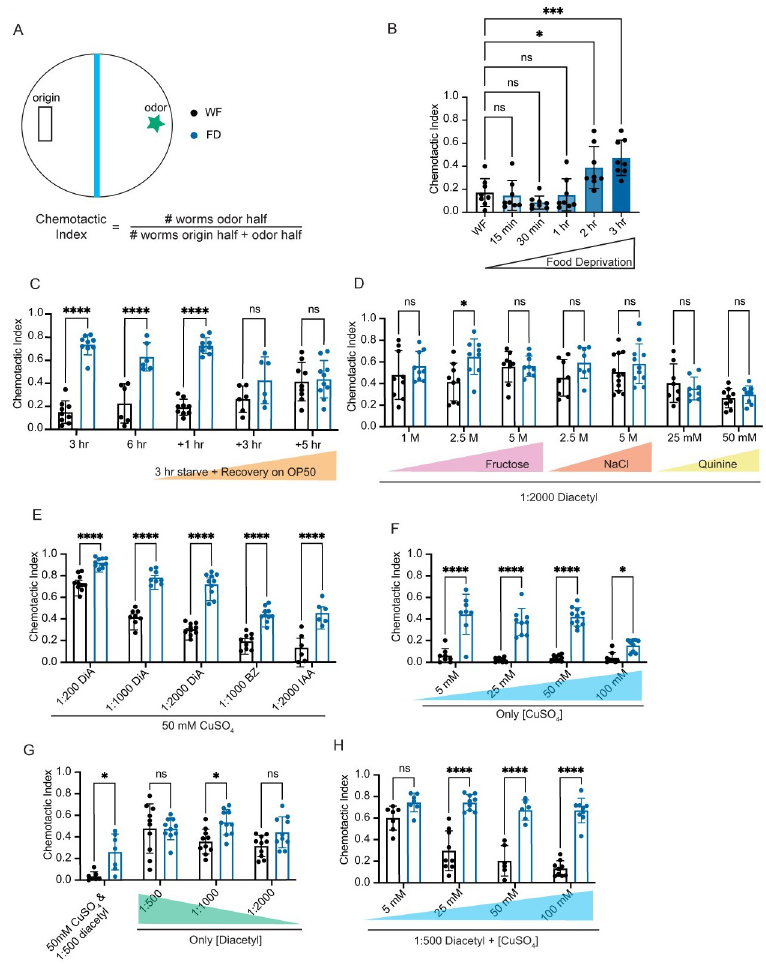
Fig 1. Starvation reduces copper avoidance. A) Schematic of the sensory integration assay. ~100–200 day 1 adult animals (n) are placed in the black rectangle. Blue barrier represents copper barrier (or other repellant) and star represents diacetyl or other attractant. Chemotactic Index is the number of animals that have crossed the barrier (odor side) divided by the total number of animals on the plate (odor + origin sides). Experiments with well-fed (WF) animals will appear with black dots and those with food-deprived (FD) animals will be indicated with blue dots. Unless otherwise noted, FD is 3 hrs with no food. Each dot represents a single plate (N) of animals (n). B) Animals are deprived of food for increasing periods of time (15 mins, 30 mins, 2 hrs, 3 hrs). Animals are exposed to 50 mM CuSO 4 repellant and 1:500 (0.2%) diacetyl attractant. N = 8. C) Sensory integration behaviors of animals that have been starved for 3 hrs and 6 hrs. Animals that have been starved for 3 hours are allowed to recover for 1, 3, or 5 hrs on OP50. Well-fed matched partners are kept on OP50 plates for the entire length of the experiment. Animals are exposed to 50 mM CuSO 4 repellant and 1:500 (0.2%) diacetyl attractant. N � 6. D) Animals are exposed to increasing concentrations of other repellants (Fructose, NaCl, Quinine) with the attractant 0.05% diacetyl (1:2000) in each condition N � 7. E) Animals are exposed to decreasing concentrations of diacetyl (DiA) (0.2%, 0.1% and 0.05%, or 1:200, 1:1000, and 1:2000, respectively) and other volatile attractants 0.1% Benzaldehyde (BZ) and 0.05% Isoamyl Alcohol (IAA). 50 mM CuSO 4 is the repellant in each condition N � 6. F) Animals are exposed to CuSO 4 in increasing concentrations (5 mM, 25 mM, 50 mM, 100 mM) without any attractant N � 8. G) Animals are exposed to diacetyl alone in decreasing concentrations (0.2%, 0.1%, 0.05%). Full assay (0.2% diacetyl and 50 mM CuSO 4 ) is included as a control N � 7. H) Animals are exposed to 1:500 diacetyl and increasing concentrations of CuSO 4 (5 mM, 25 mM, 50 mM, 100 mM) N � 6. All graphs are analyzed using a two-way ANOVA, determined to have significant differences across well-fed and food-deprived conditions. WF/FD comparisons were then performed as pairwise comparisons within each genotype or treatment as t-tests with Bonferroni corrections for multiple comparisons. � p < 0.5, �� p < 0.01, ��� p < 0.001, ���� p < 0.0001, ns p > 0.05. Error bars are S.D.